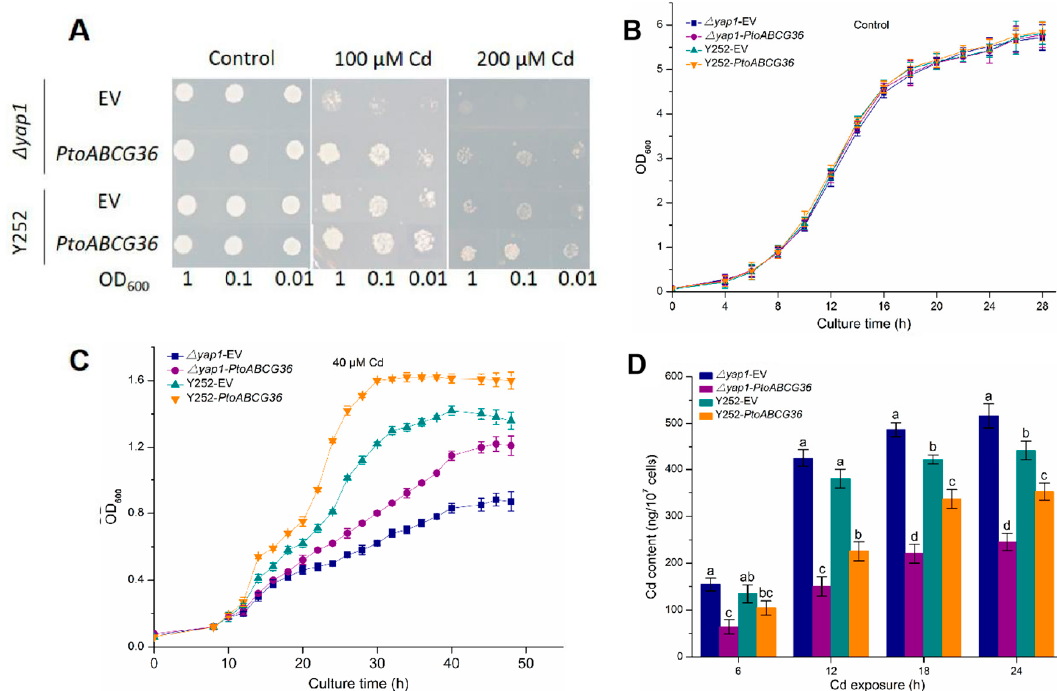
Figure 4. PtoABCG36 enhances cadmium tolerance in yeasts. ( A ) Δ yap1 and the wild-type Y252 were transformed with EV (pDR196 empty vector) and pDR196- PtoABCG36 , and grown on SD plates with indicated concentrations of CdCl 2 for 7 d. ( B , C ) Growth curves of yeast cells Δ yap1 -EV (square), Δ yap1- PtoABCG36 (circle) , Y252- EV (up-triangle) and Y252- PtoABCG36 (down-triangle) under control ( B ) and 40 µM CdCl 2 condition ( C ) for indicated time. ( D ) Accumulation of cadmium in Δ yap1 -EV (navy blue), Δ yap1-PtoABCG36 (purple) , Y252-EV (dark cyan) and Y252- PtoABCG36 (orange) yeasts. Yeast cells (1 × 10 7 ) were exposed to 40 µM Cd treatment for 6, 12, 18 or 24 h at 30 °C. Cd concentrations in the yeast cells were measured by ICP-OES. Error bars indicate standard deviation ( n = 3). Different letters indicated significant differences ( p < 0.05) .